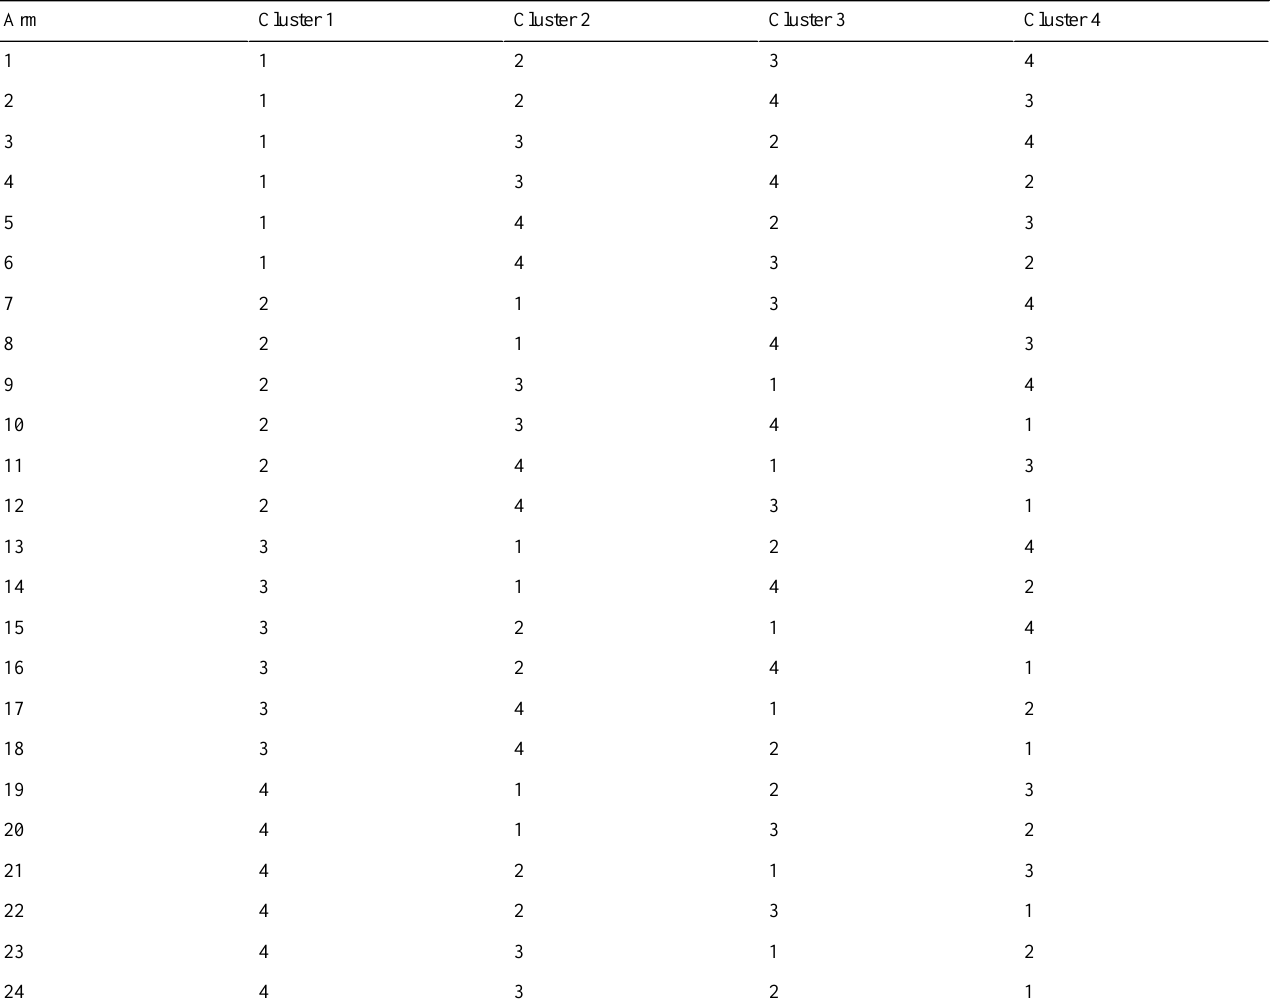
Table 1. Order combinations of the 4 item clusters creating 24 trial arms.